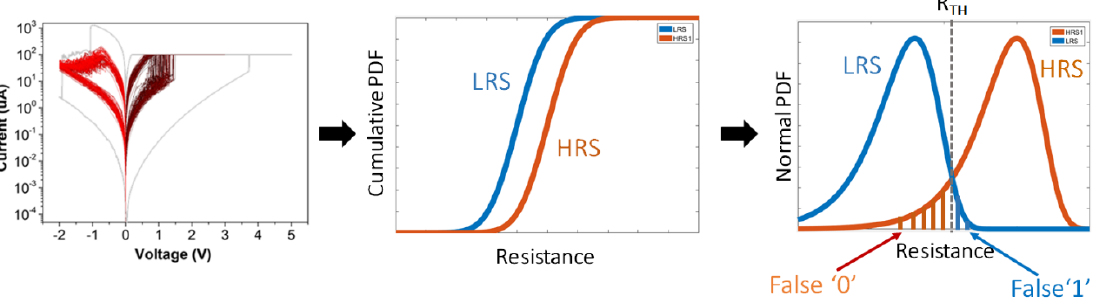
Figure 8. RRAM resistance coded to digital logic-0/1 with false logic-0/1 condition explained on a normal pdf plot of low resistant state (LRS) and high resistant state (HRS) resistance data.